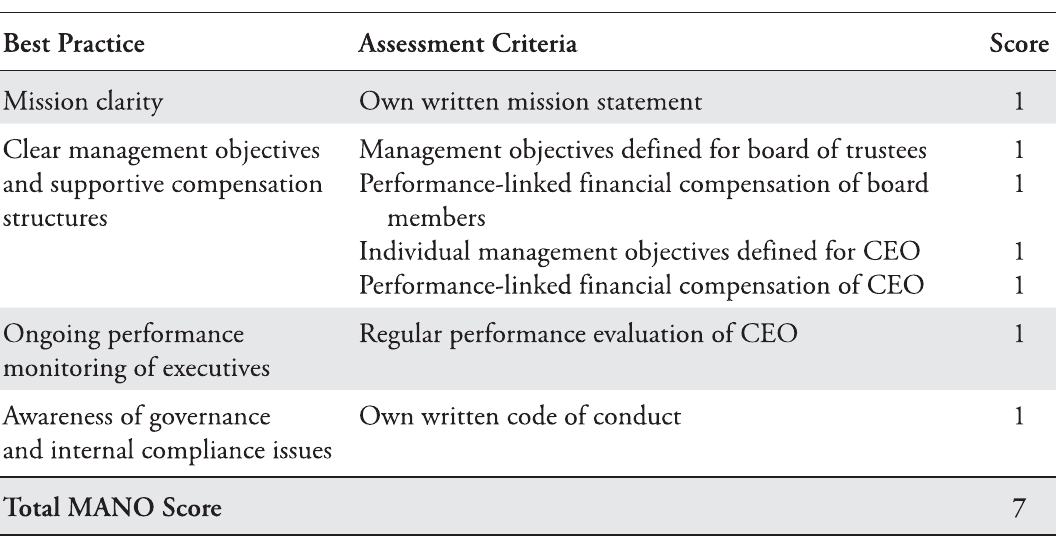
Table 2: Composition of the MANO